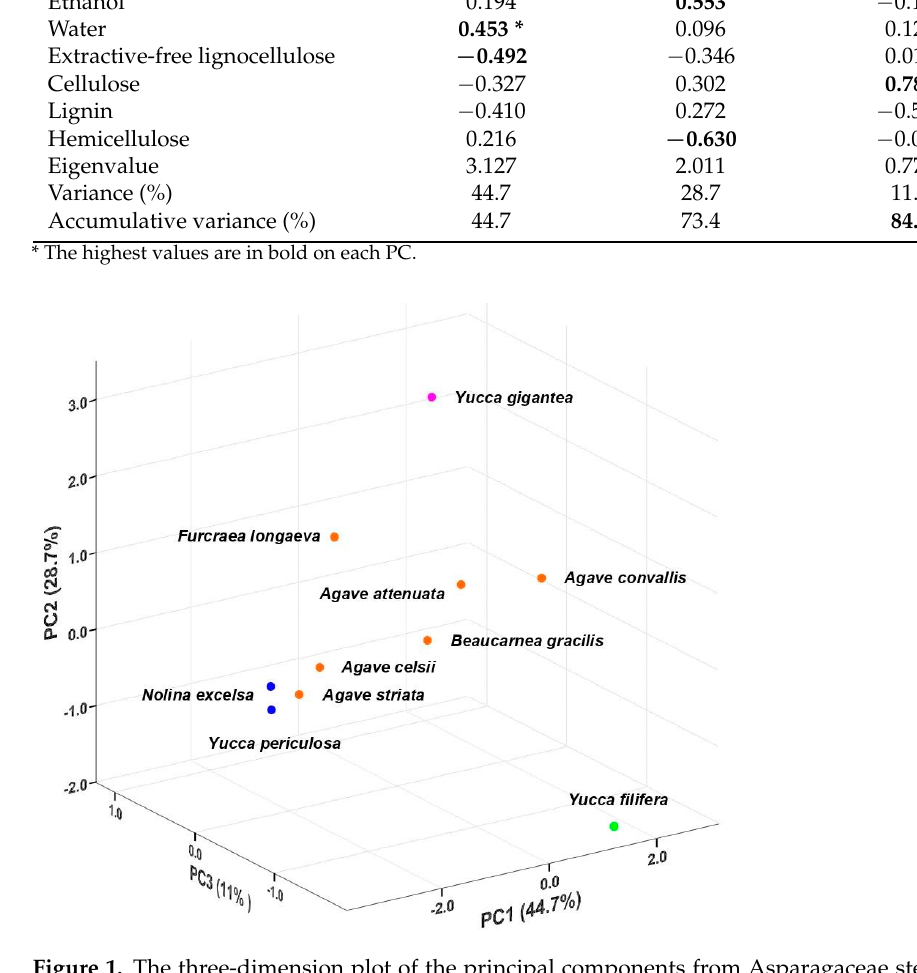
Figure 1. The three − dimension plot of the principal components from Asparagaceae stems. Blue Figure 1. The three-dimension plot of the principal components from Asparagaceae stems. Blue points: group 1, green point: group 2, pink point: group 3, brown point: group 4. points: group 1, green point: group 2, pink point: group 3, brown point: group